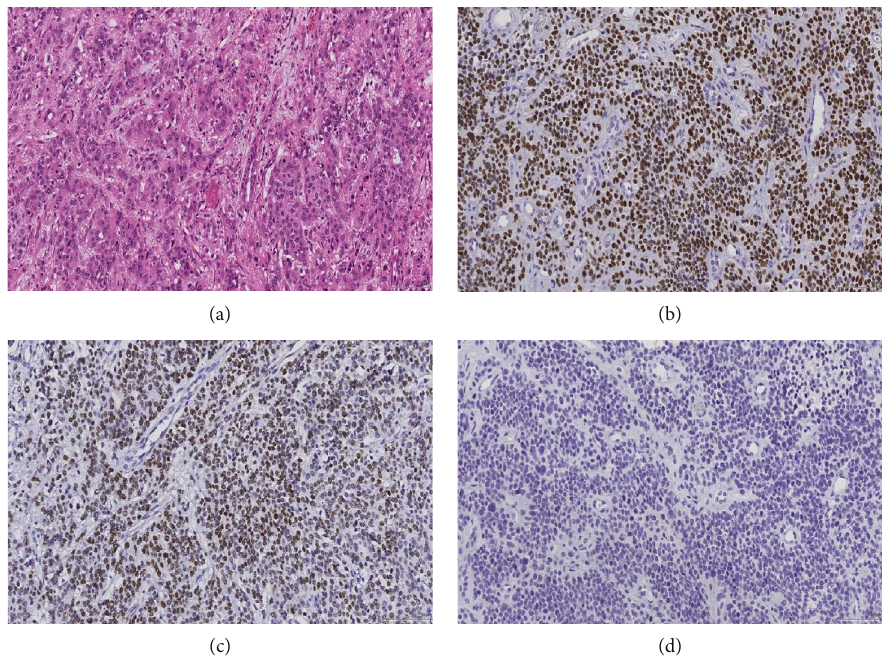
Figure 1: (a) The nephrectomy specimen demonstrated in fi ltrative nests of tumor cells with prominent nucleoli, moderate pleomorphism, and scattered mitoses (H&E). (b) Nuclear expression for p63 in the tumor cells supports the diagnosis of urothelial carcinoma. (c) SV40/BKV stain showing positive staining in the tumor cells. (d) PAX8 is negative in tumor cells, excluding renal cell